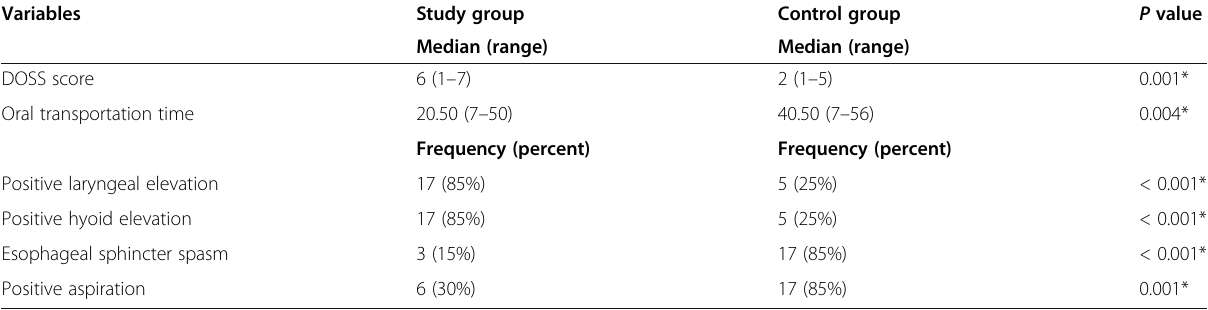
Table 5 Comparison of the DOSS score and different components of the digital fluoroscopic evaluation post-treatment between groups A and B Variables